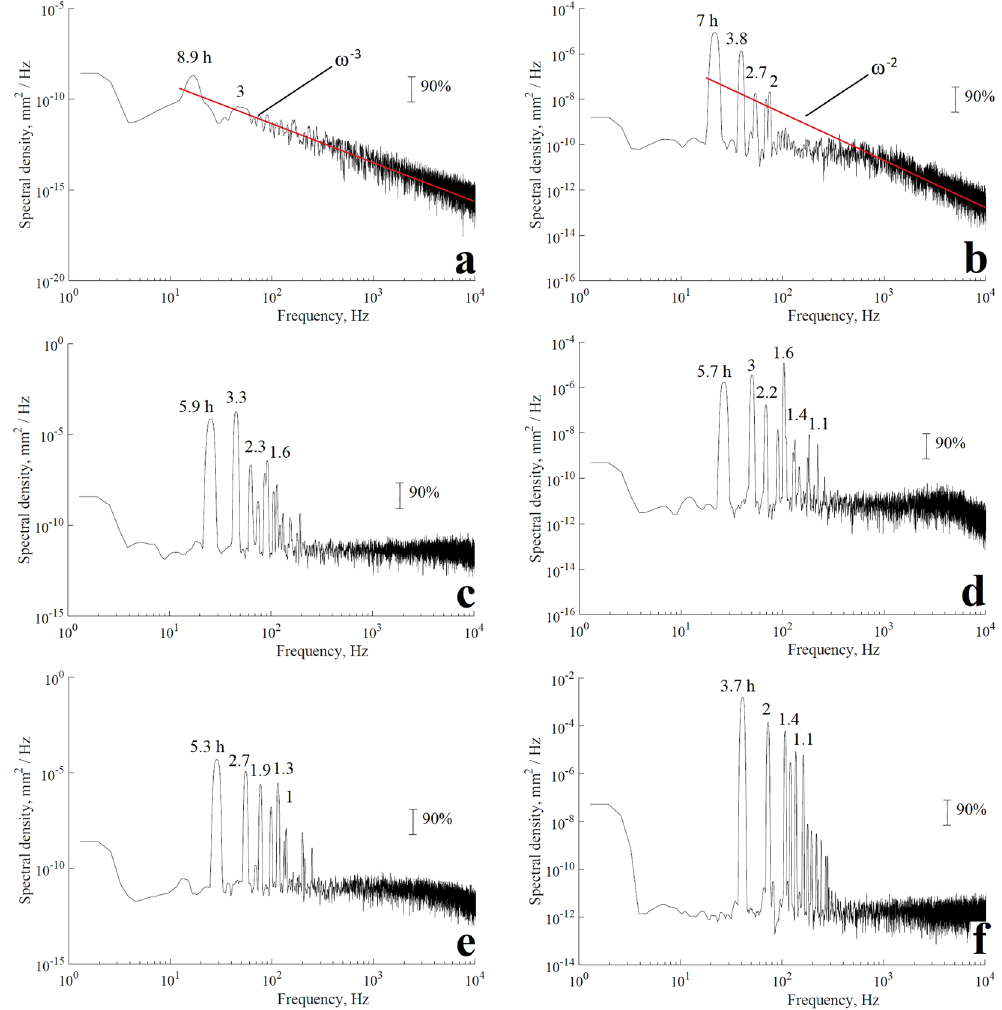
Figure 8. Frequency spectra of the modelled water level fluctuations in the lake at the west site from the different water storage levels (from isobaths 90 to 95 m). Arabic numerals show the period of the main peaks in the spectrum. The vertical line shows the 90% confidence interval with 10 degrees of